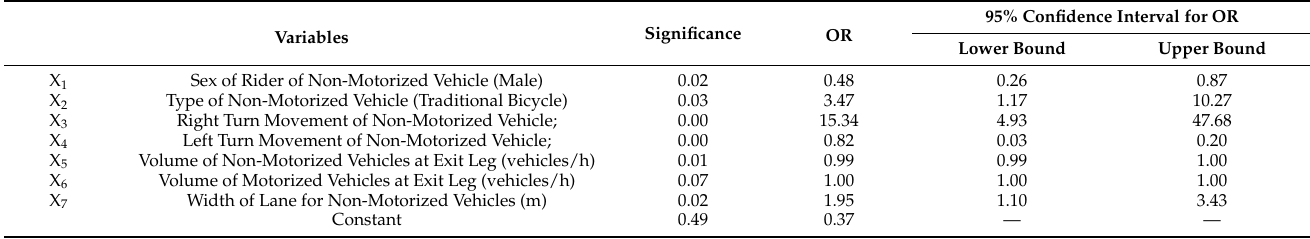
Table 3. Binary logistic model for lane choice of riders of non-motorized